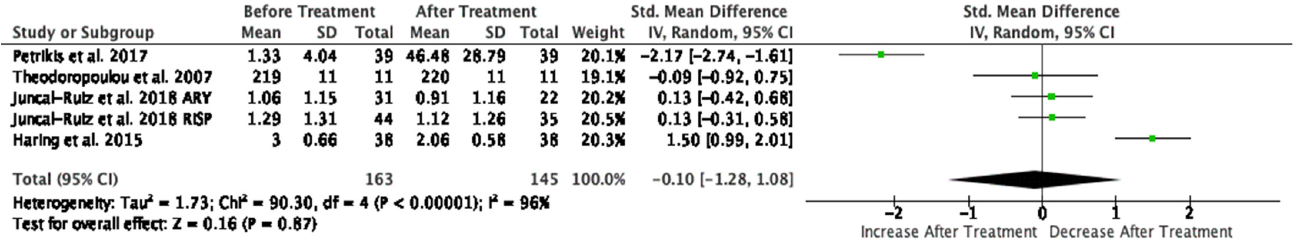
Figure 5. Meta-analysis of IL-2.